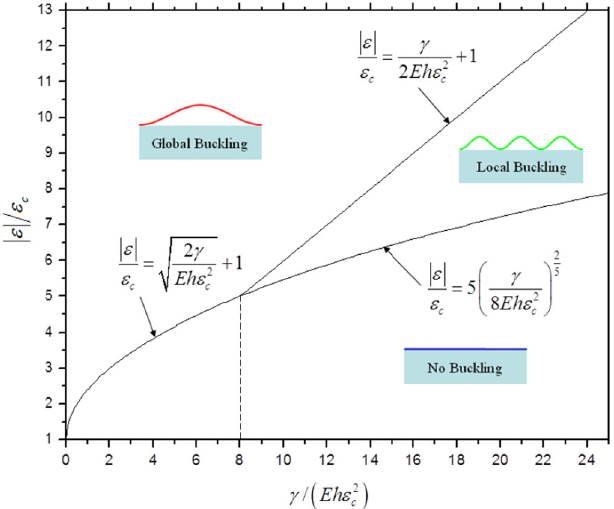
Fig. 5 Deformation map for different buckling modes (normalized strain vs. work of adhesion). (Reprinted with permission from Ref. 35)